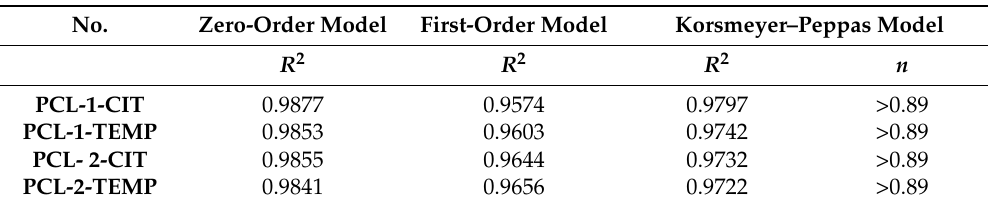
Table 4. Analysis data of peptide release from polymeric matrices.